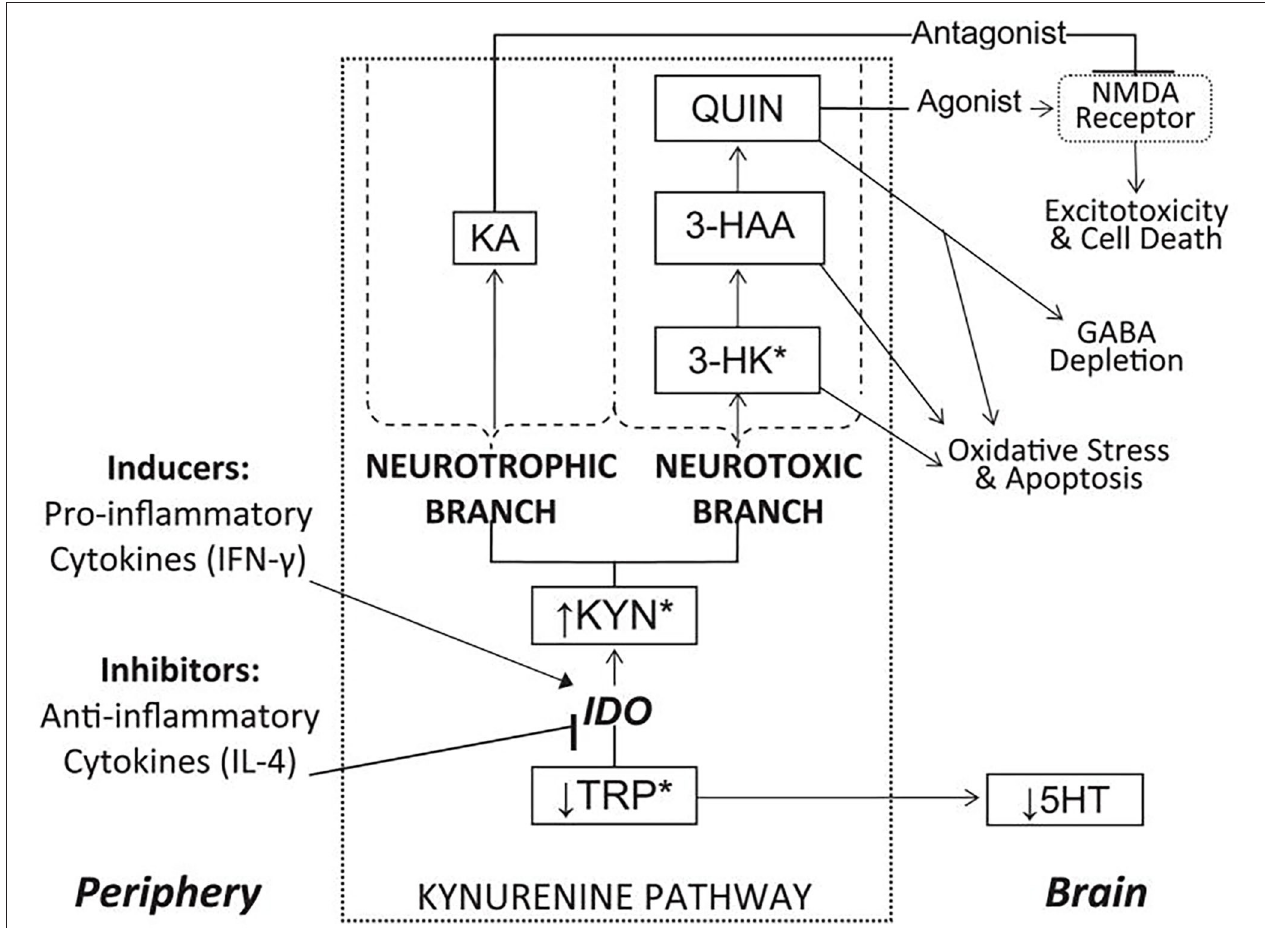
FIGURE 12 | Overview of the kynurenine pathway and its position as a link between peripheral inflammation and central reward circuitry disruption. See list of acronyms at the start of main text. Reprinted from ( 204). * Metabolites capable of crossing the blood-brain barrier.